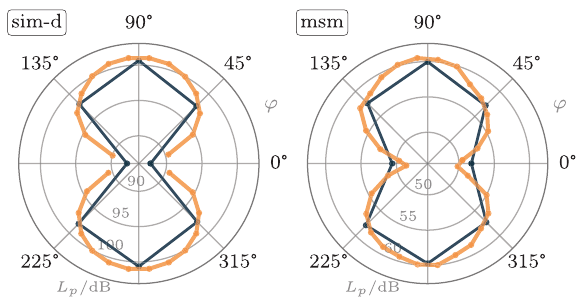
Figure 14. Directivity patterns (sim-d and msm) in the xy plane for the 4 kHz octave band, displayed dynamic 15 dB, blue: ES 18 , orange: EA 512 .